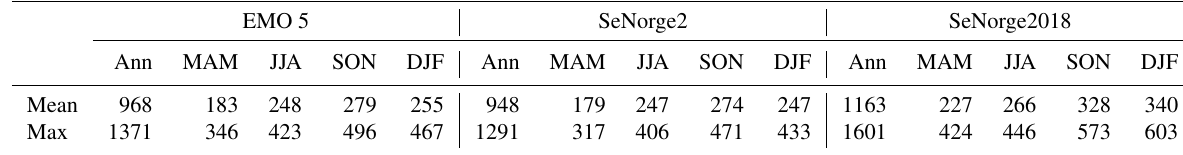
Table 6. Overview of EMO-5, seNorge2, and seNorge2018 datasets based on the common period 1990–2015 [mm]. The order of calculation is first to calculate the parameters (mean, maximum) for the grids, followed by the mean over the resulting grid.